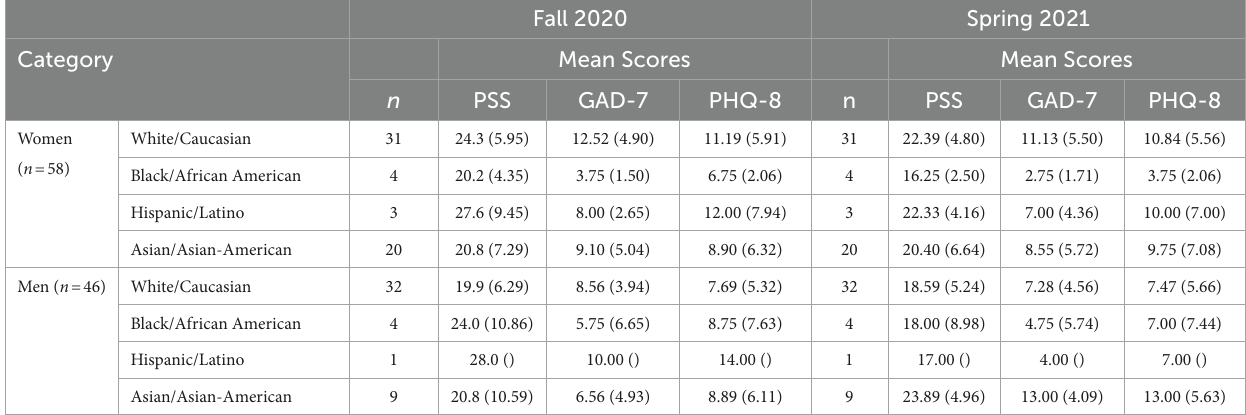
TABLE 4 Longitudinal participants’ mental health Fall 2020 to Spring